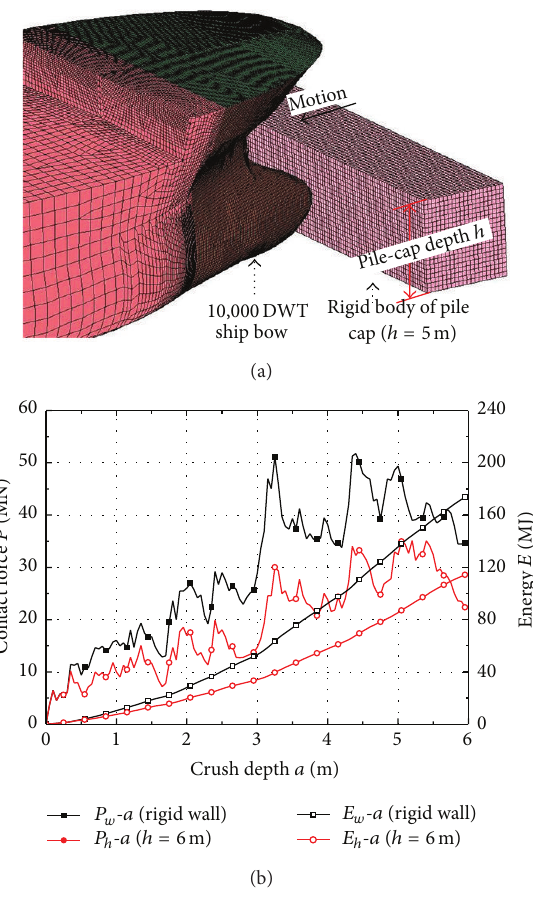
Figure 15: (a) Finite element model of ship collision with pile cap (10,000 DWT); (b) P-a curve and E-a curve of rigid wall versus pile cap ( ℎ = 6 m, 10,000 DWT).